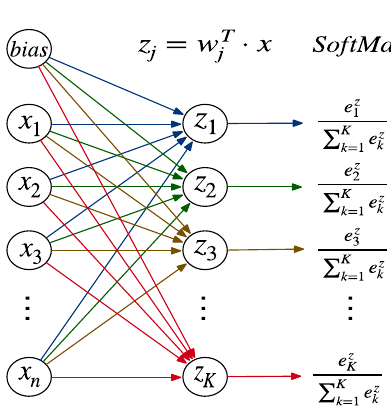
Figure 3. Multi-class fully connected and Softmax layers.